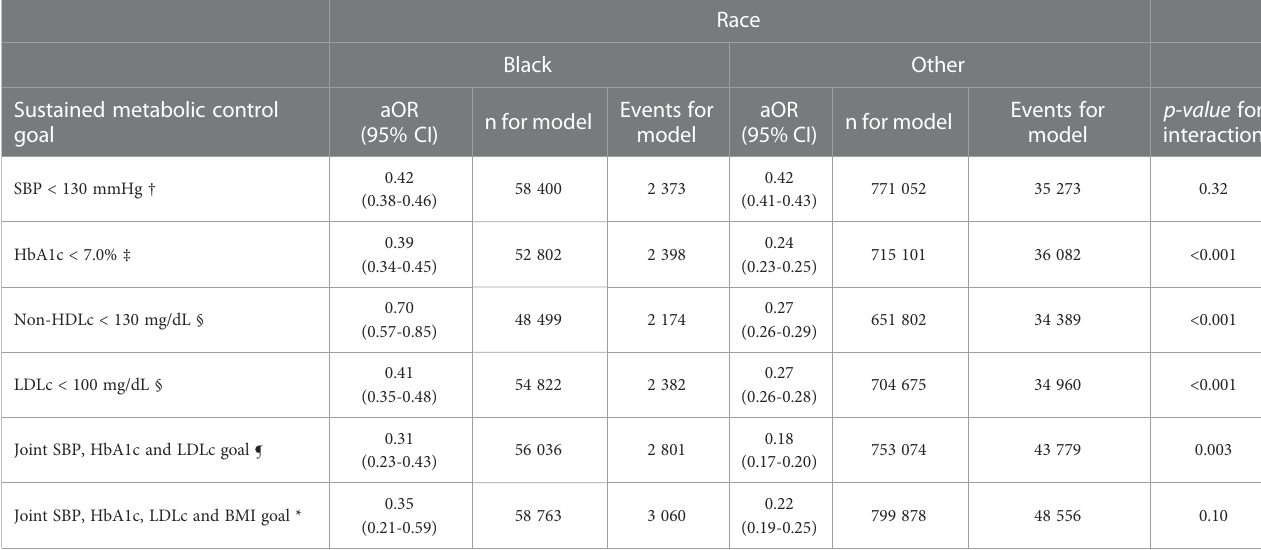
TABLE 2 Association between sustained metabolic control and mortality, by race.